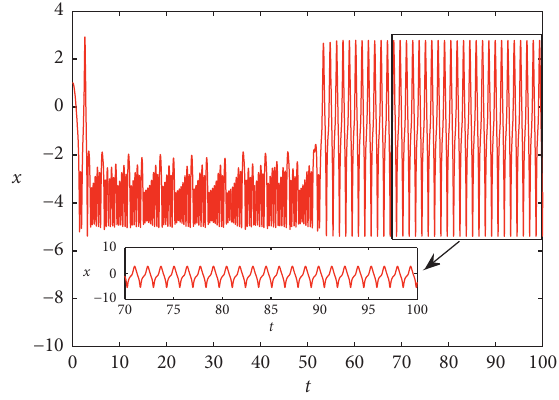
Waveform plot of system (7) near , τ ) � (− 2 . 902 , 0 . 344 ) with parameters ( μ ( d 0 0 0 . 1664 ) , τ � 0 . 5104, tspan � [ 0 , 100 ] , and ( x